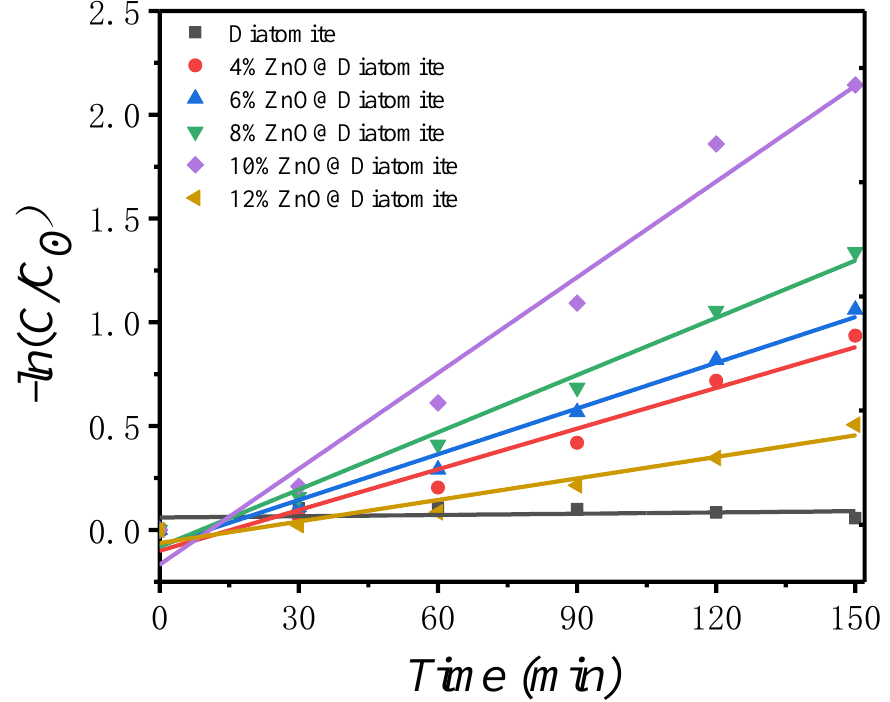
Figure 11. Primary kinetics fitting curve for photocatalytic degradation of MB.